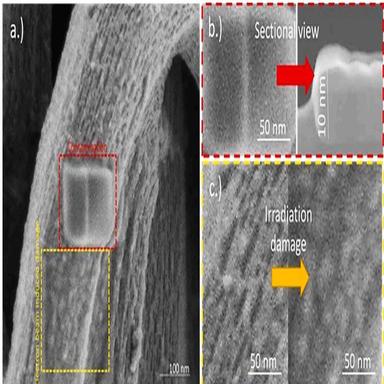
The possible negative effects of electron beam irradiation on Au-loaded SBA-15 mesoporous silica during its imaging are shown. The figure shows SLEEM images taken after irradiation of the sample with 2 keV electron beam (b.)) and 30 keV electron beam (c.)). The red boxes (b.)) display how a longer irradiation time with 2 keV electron beam causes contamination of the sample whereas the yellow boxes show how a higher electron dose (2 C/cm2 ) causes also irradiation damage on the structures of mesoporous silic